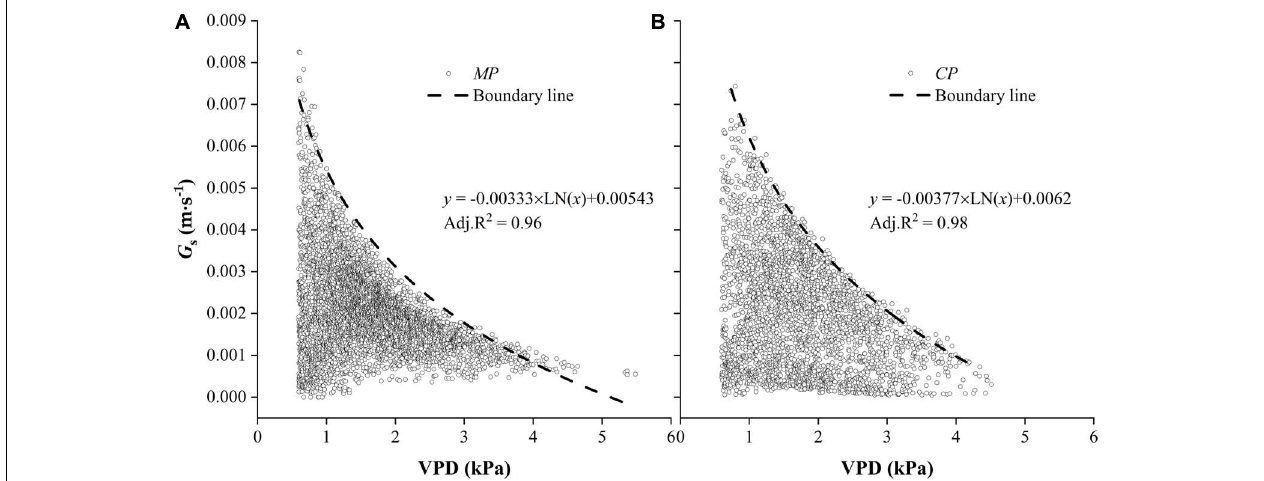
FIGURE 10 | Hourly values of canopy conductance, G s varied with vapor pressure deficit, VPD for two tree species Mongolian Scots pine ( MP ) (A) and Chinese pine ( CP ) (B) . Data were selected when daytime VPD was higher than 0.6 kPa. The dotted line shows the fitted boundary curves suing a logarithmic